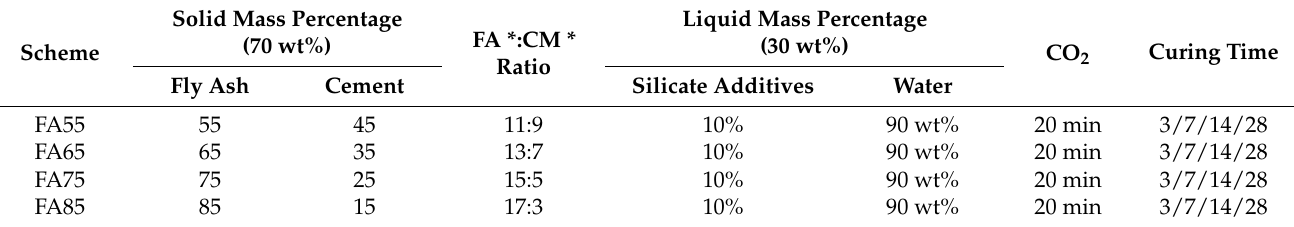
Table 1. The schemes of material ratios of CMFB.